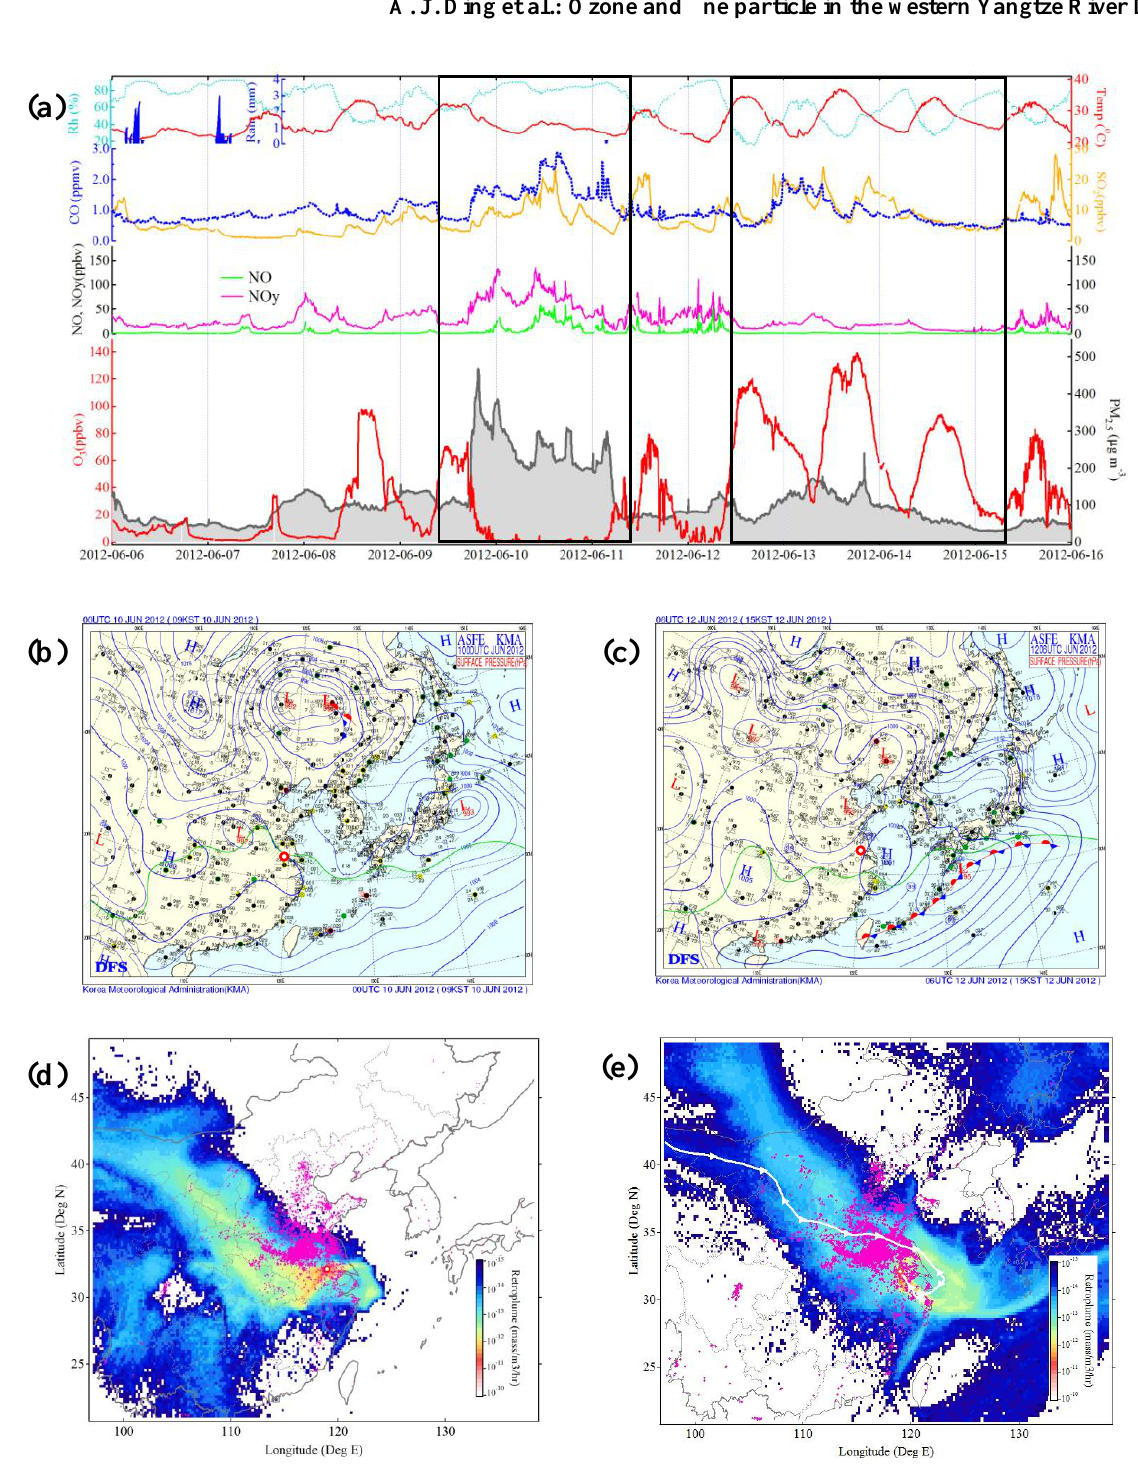
, PM , related trace gases and meteorological parameters for 1 3 2.5